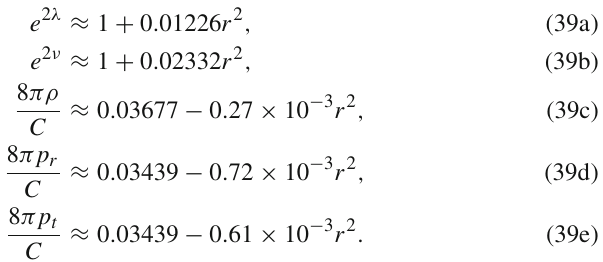
can generate stars from the exact solution (26) which are